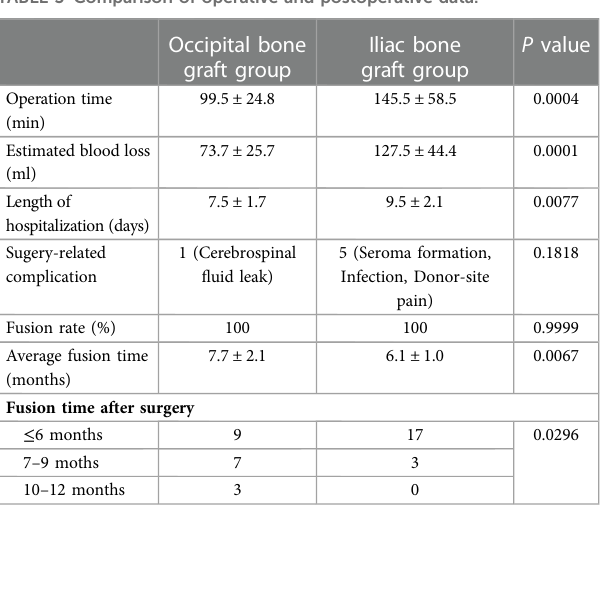
TABLE 3 Comparison of operative and postoperative data.